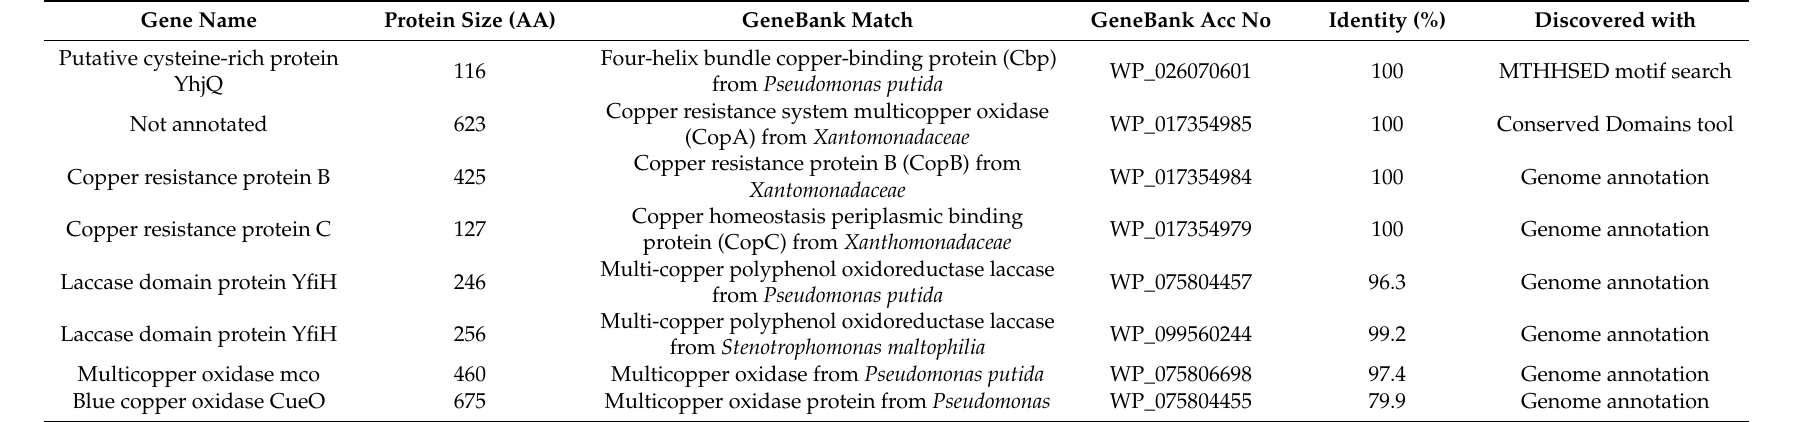
Table 2. Genes coding for proteins with laccase-like activity discovered in genome of P. putida